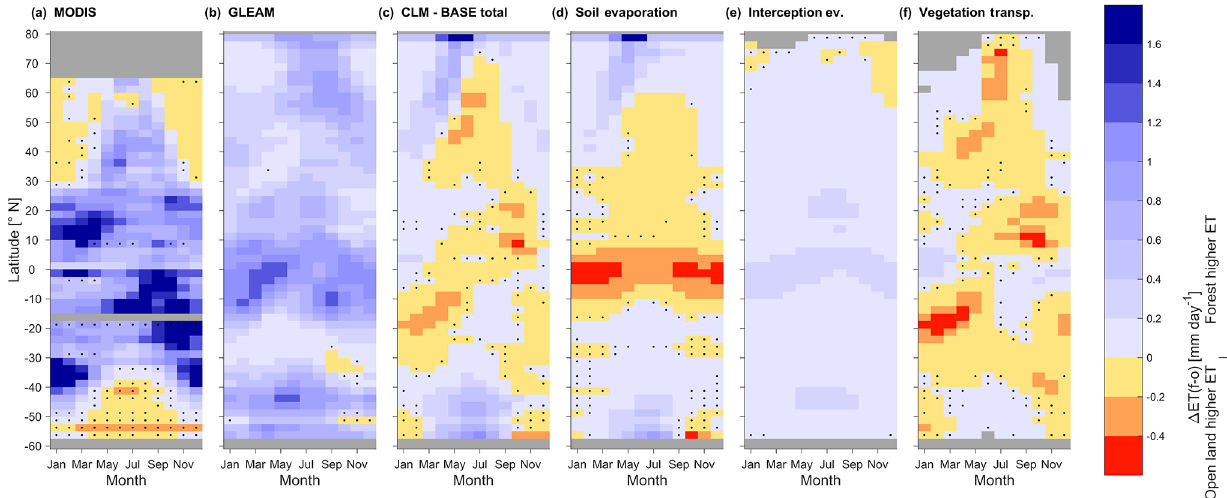
Figure 7. Seasonal and latitudinal variations of (cid:49) ET (f − o) in (a) MODIS, (b) GLEAM, and difference of forest minus open land in (c) total ET, (d) soil evaporation, (e) canopy interception evaporation, and (f) vegetation transpiration in CLM-BASE. Points with a mean which is insignificantly different from zero in a two-sided t test at 95% confidence level are marked with a black